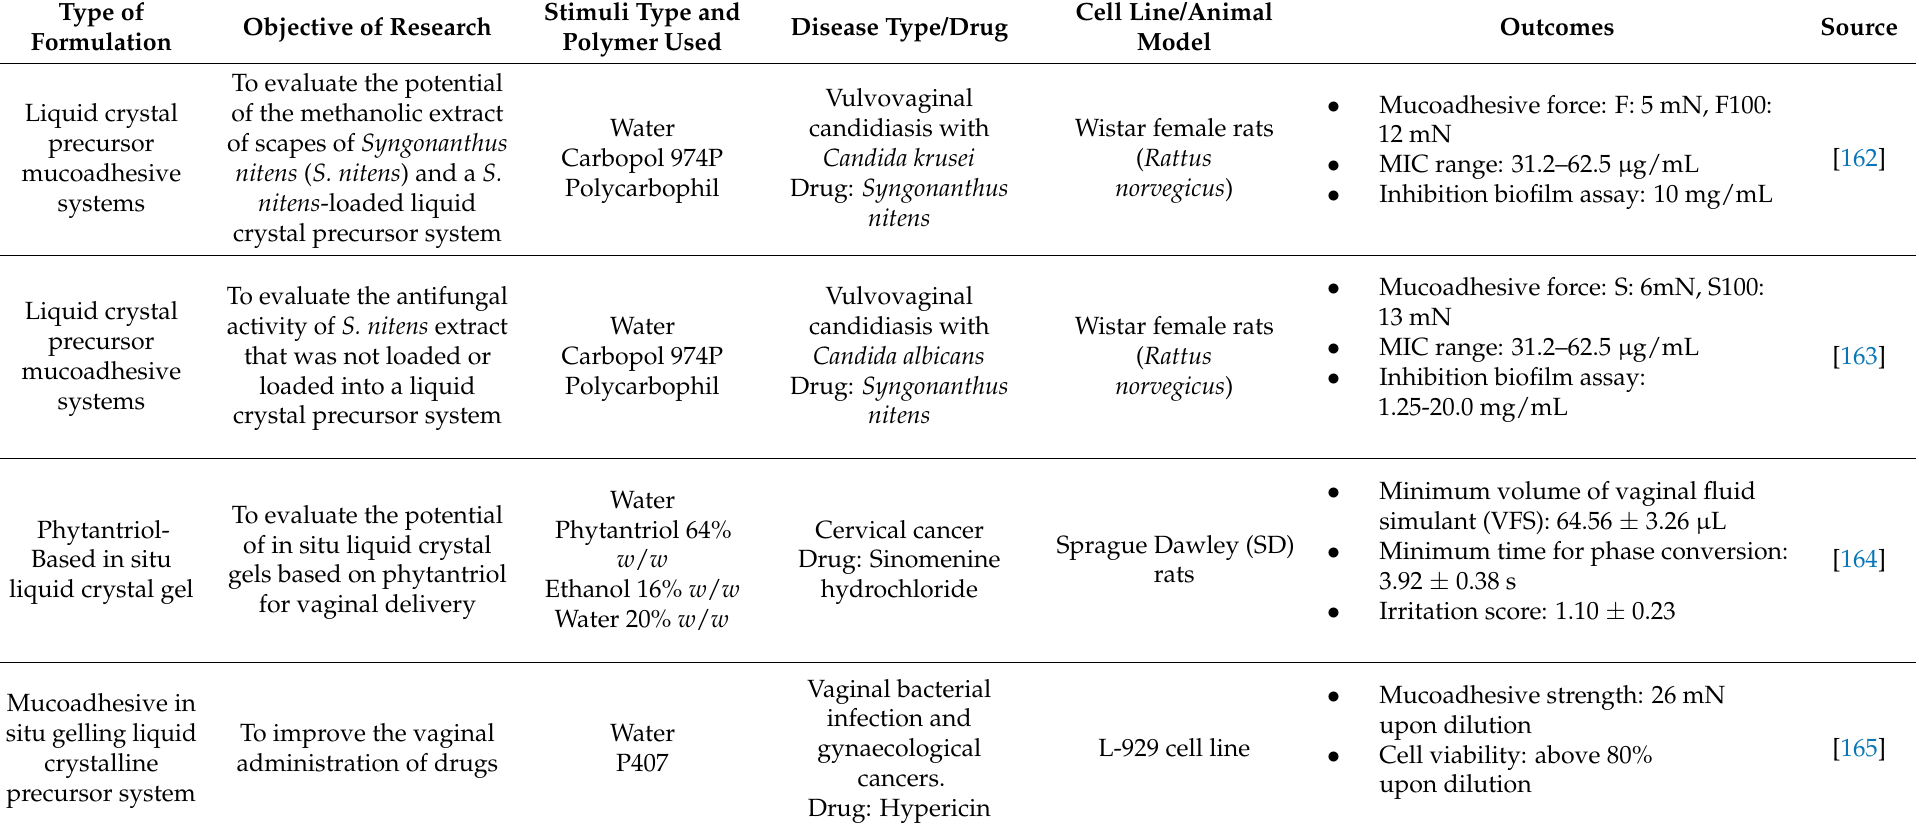
Table 7. Liquid crystalline precursor systems for vaginal drug